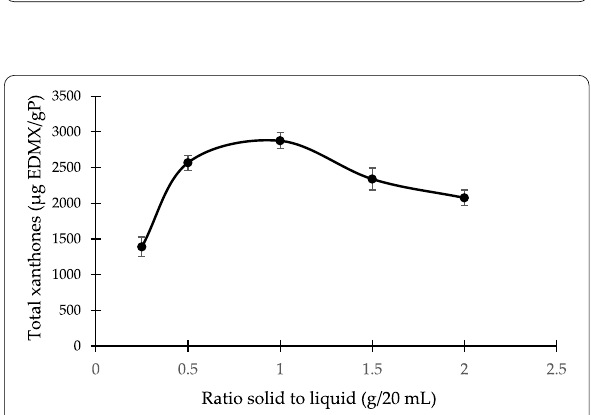
Fig. 4 Effect of solid-to-liquid ratio on the concentration of xanthones during microwave-assisted